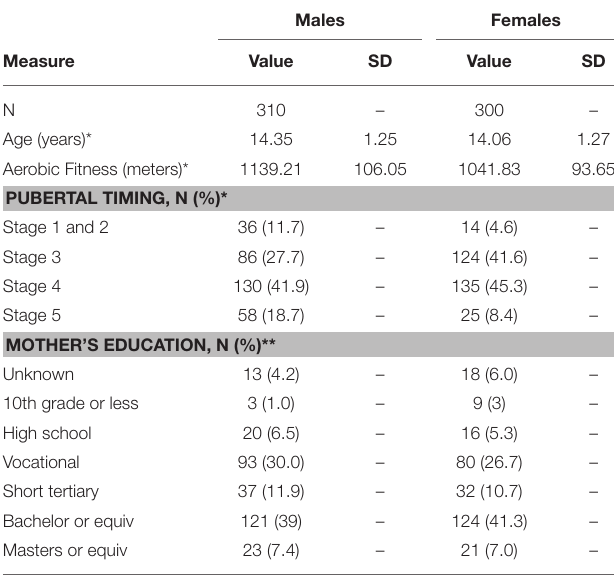
TABLE 1 | Demographic Information, mean, and SD by